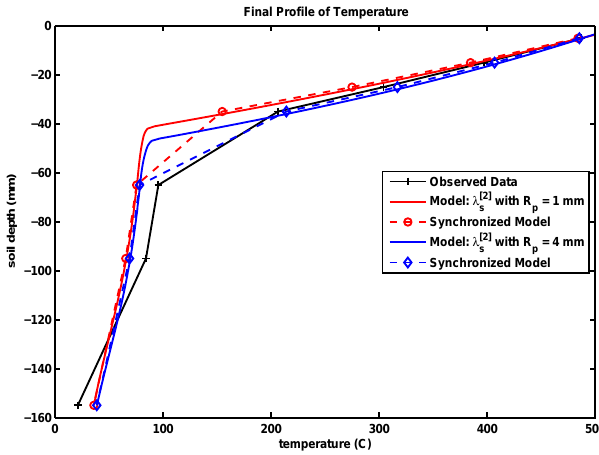
Figure 5. Comparison of the final modeled and measured temper- ature profiles at the completion of the 90min Quincy Sand heating experiment. Because the data shown in the measured profile (black) are not precisely coincident in time, the full model results (solid red and blue lines) were sub-sampled in synchrony in time (and coincide in space) with the observations. These time-synchronized model profiles are shown as dashed red and blue lines. To compare with the equilibrium model, see Fig. 6 of Massman